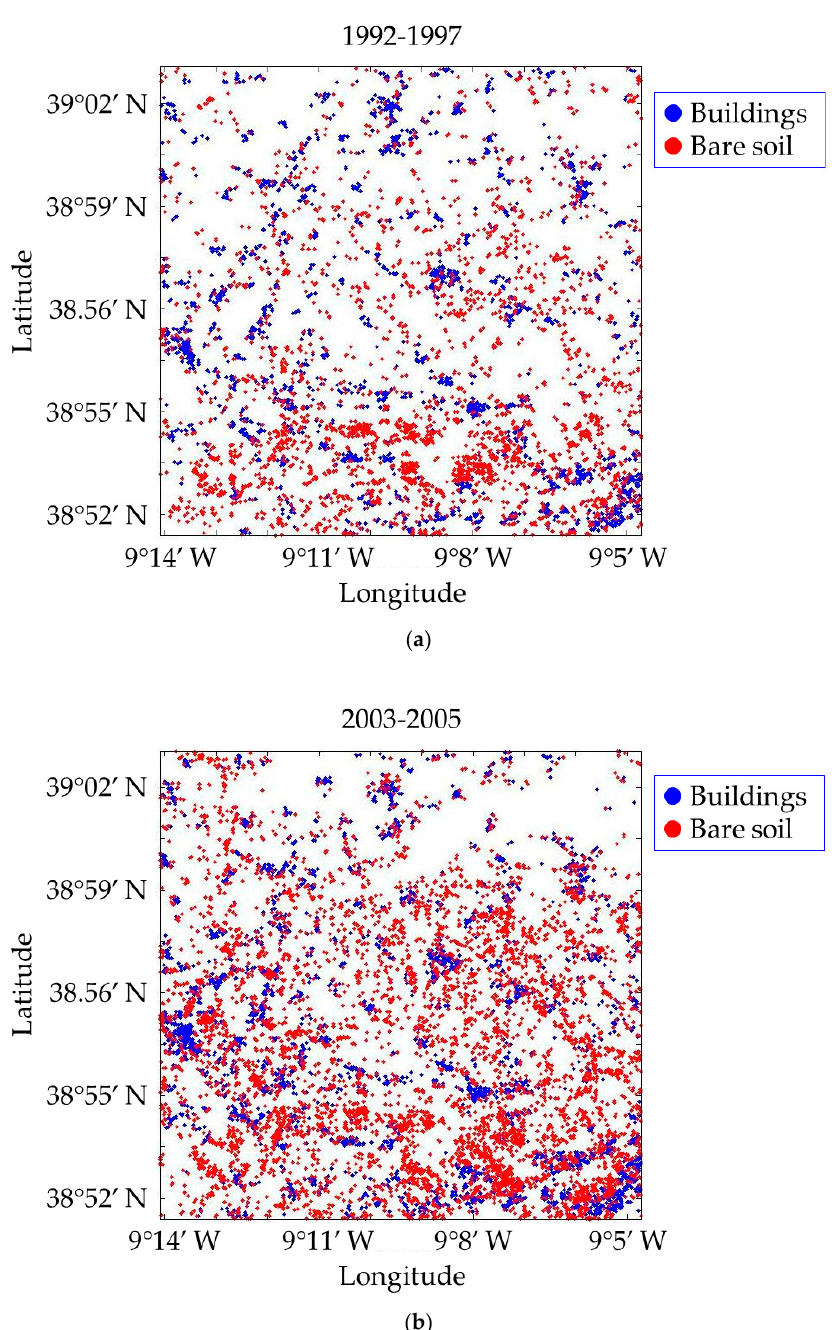
Figure 4. Location of Persistent Scatterers: ERS 1992–1997 ( a ) and ENVISAT 2003–2005 ( b ). The largest spatial density of PS’ and the fraction of those corresponding to bare or sparsely vegetated soil were found in the time series 2003–2005, elapsing the shortest time interval and containing only 14 SAR images. In contrast, in the time series 1992–1997, the smaller spatial density and the largest fraction of PS related to buildings were found. Figure 5 shows, from the top to the bottom and from the left to the right, the frequency distributions of LU, slope and aspect classes and the PS frequency distributions in terms of lithology, slope and aspect angles, normalized to the area of LU classes for the ERS time series.